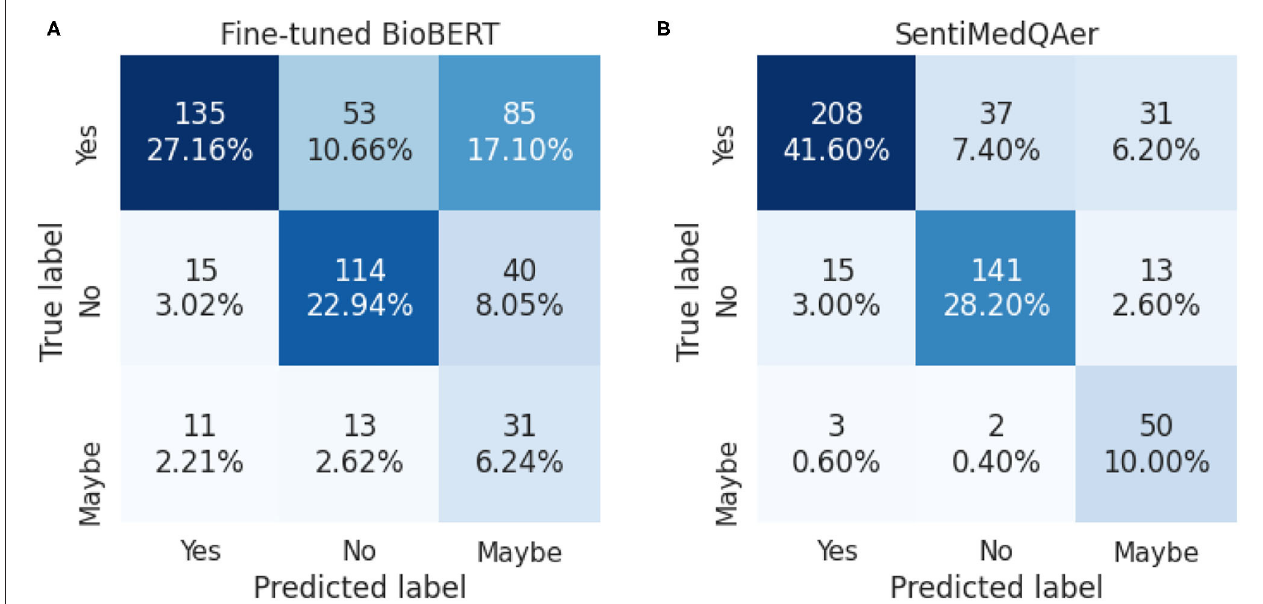
FIGURE 2 | Confusion matrices for (A) the fine-tuned BioBERT and (B)